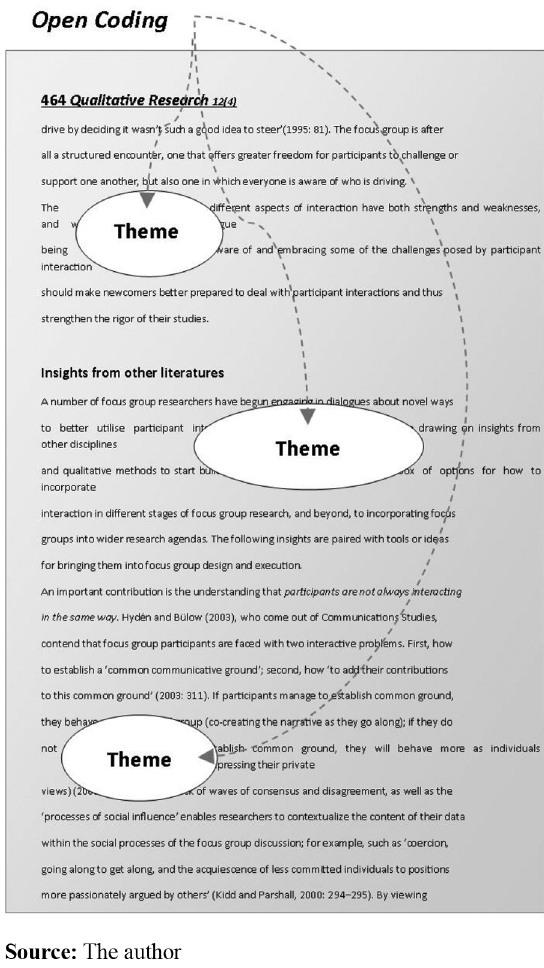
Figure 1. Emergence of